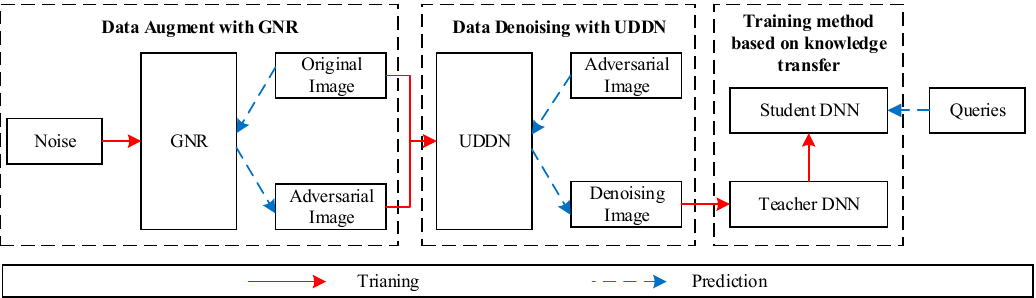
Figure 5. Overview of the defending approach. The approach consists of three stages. The first stage is expending adversarial images with GNR. The second stage is training the UDDN to denoising the attack images. The third stage is training the published model based on knowledge transfer.